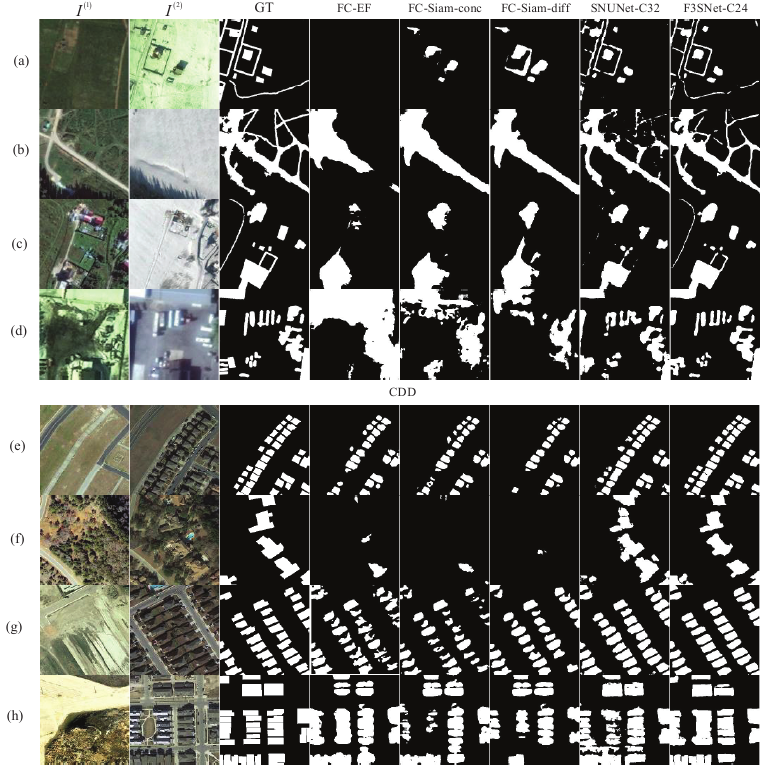
Figure 7. Visualisation results of different methods on the CDD [43] and LEVIR-CD [34] test sets. F3SNet has C = 24 on the CDD test set and C = 8 on the LEVIR-CD test set. In addition, Table 2 shows the training time and test time for 30,000 pairs of images of size 256 × 256 pixels. For a fair comparison, we adopt the same batch size (16) for all the